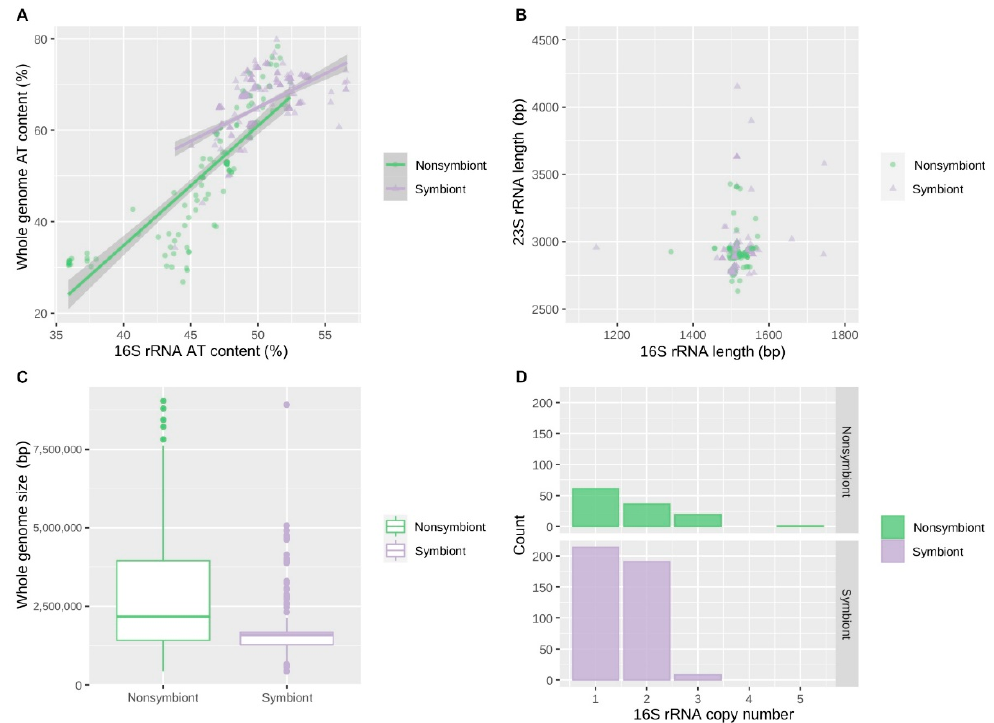
Figure 6. Comparisons of genomic features between symbiotic bacteria and nonsymbiotic bacteria with unlinked rRNA operons. The di ff erences in genomic features between symbionts and nonsymbionts that have only unlinked rRNA operons are displayed. ( A ) The AT content of the whole genome sequence and the average AT content of 16S rRNAs in each bacterial genome were plotted with the linear regression and the 95% confidence intervals. The AT content of the genome and 16S rRNA was significantly di ff erent between symbionts and nonsymbionts ( p < 0.001). ( B ) The average length of the 16S rRNAs and 23S rRNAs of each genome was plotted. ( C ) The boxplots of the whole genome size of symbionts and nonsymbionts. The whole genome size was significantly di ff erent between symbionts and nonsymbionts (the average of the whole genome size: 1.683 Mbp (symbionts), 2.923 Mbp (nonsymbionts); p < 0.001). ( D ) The histograms of 16S rRNA gene copies on genomes of symbionts and nonsymbionts.